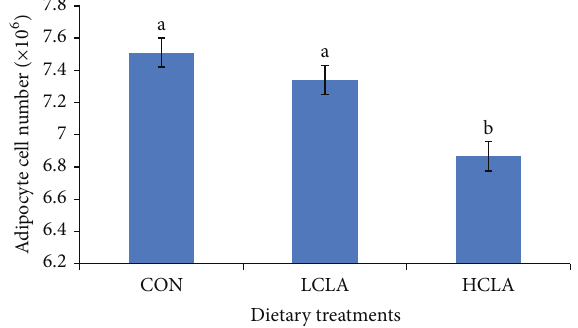
Figure 6: Effects of dietary conjugated linoleic acid (CLA) on adipocyte cell number in chickens fed with CON (control), LCLA (low conjugated linoleic acid), and HCLA (high conjugated linoleic acid) for 6 weeks. Data represents the mean of cell number. Data are presented as mean ± SEM. Different superscripts between bars denote significant differences ( 𝑃 < 0.05